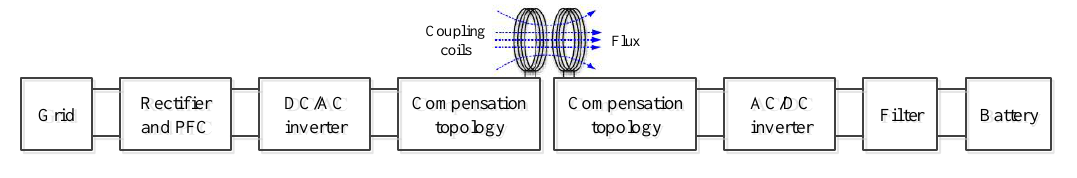
Figure 1. Components of WCS.